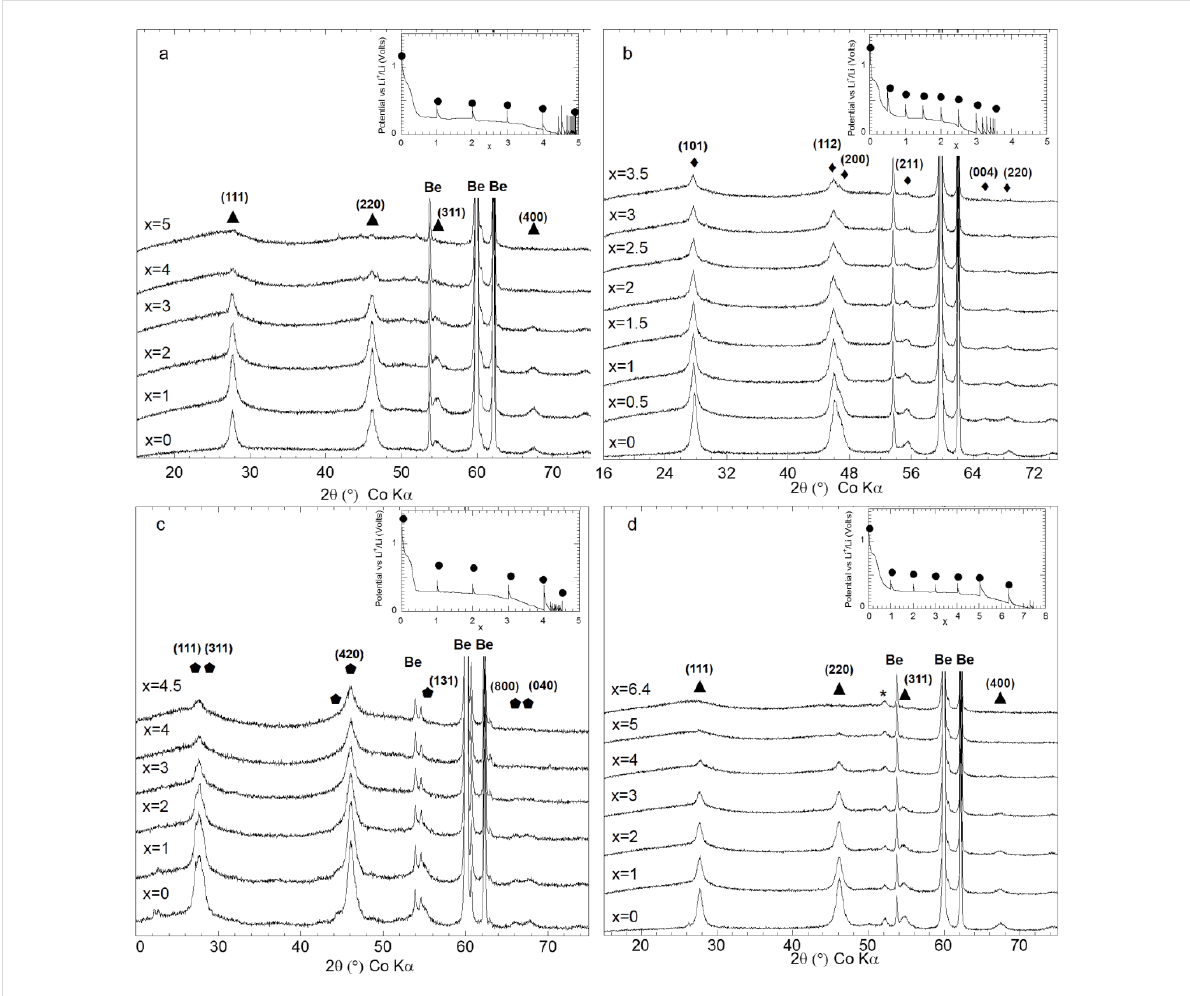
Figure 9: In situ XRD patterns of a) Mg 2 FeH 6 , b) Mg 2 CoH 5 and c) Mg 2 NiH 4 and d) Mg 2 FeH 6 -10% Ct, z electrodes prepared by reactive grinding as a function of the mole fraction of Li ( x ) Inset: Potential profile of a) b) c) and d) obtained during GITT (rate: one equivalent of Li in 10 h, relaxation time: 10 h). Adapted from [13] (copyright 2013 Elsevier) and